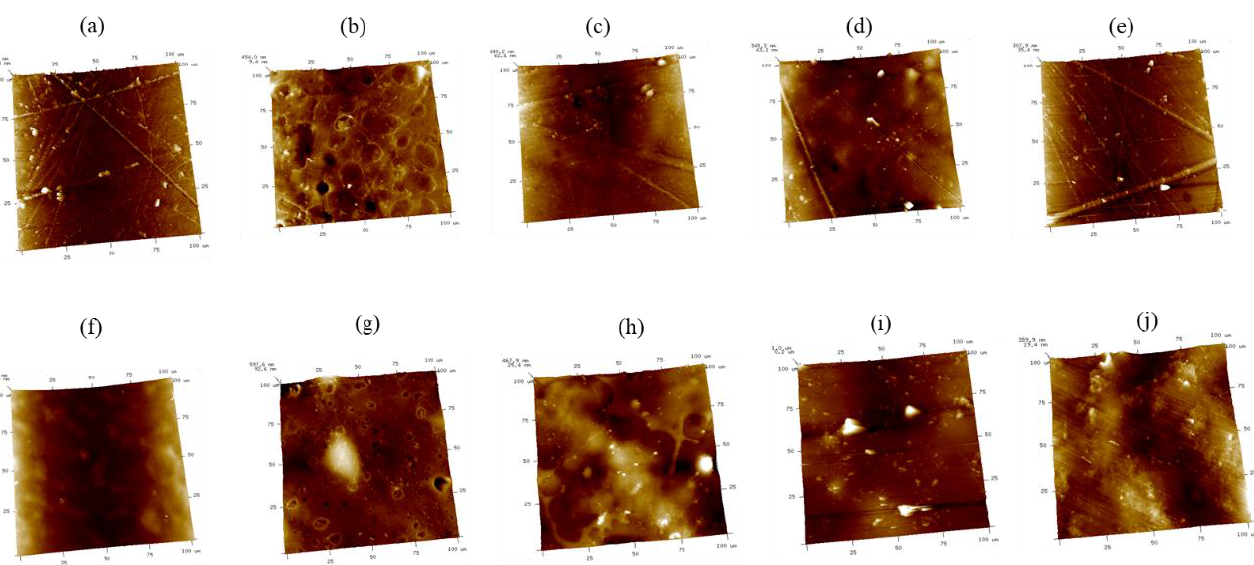
Table 5. Roughness and contact angle of GA crosslinked and PEGDE crosslinked chitosan/HNa films.